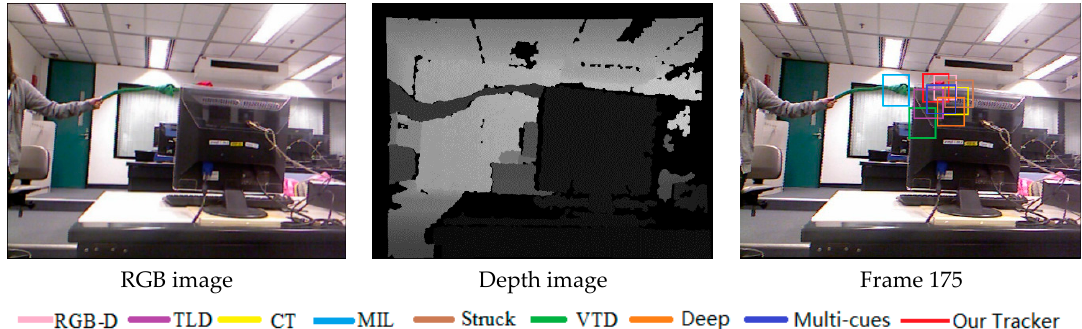
Figure 9. The tracking results on the test video 3 obtained by different methods.